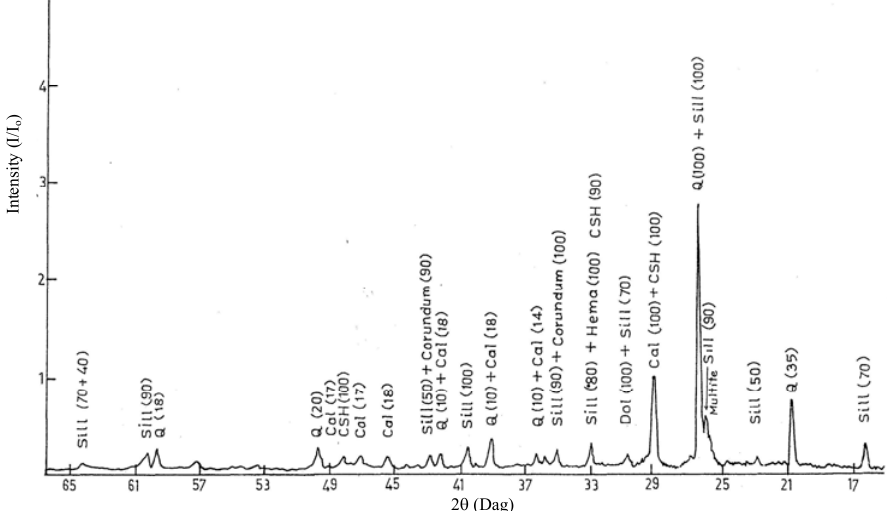
2 θ Figure 4. XRD pattern of simple lime fly ash sand (LFAS) composites